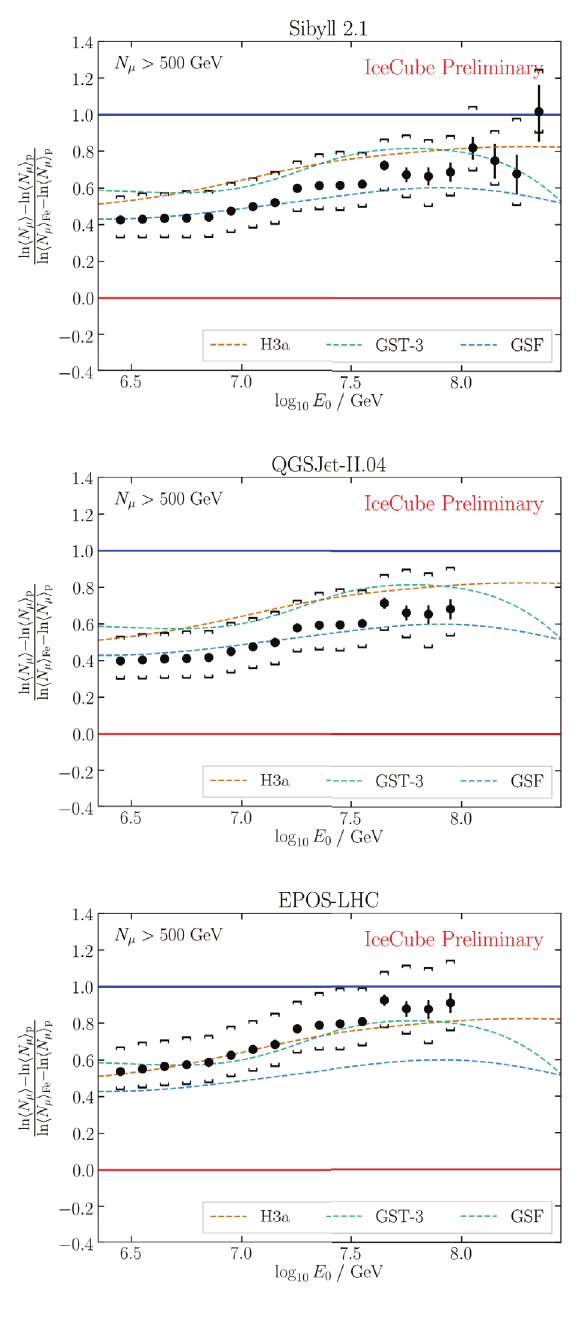
Figure 11: z -value results (Eq. 2) [12] with di ff erent hadronic interaction model assumptions, compared to ex- pectations from mass composition models. Error bars in- dicate the statistical uncertainty and the brackets indicate the total systematic